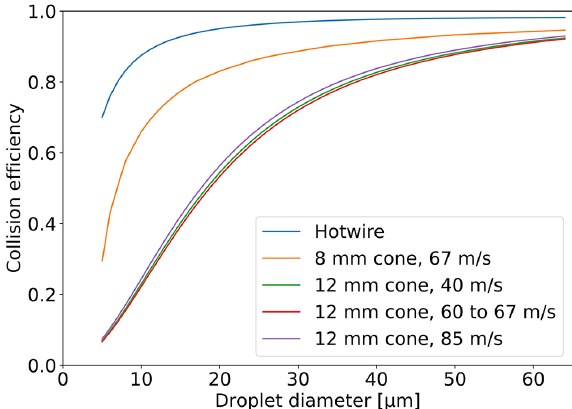
Figure 5. Collision efficiency curves of the 12mm cone for the three airspeed groups; the collision efficiencies of the LWC sensor and the 8mm cone from the literature are shown for